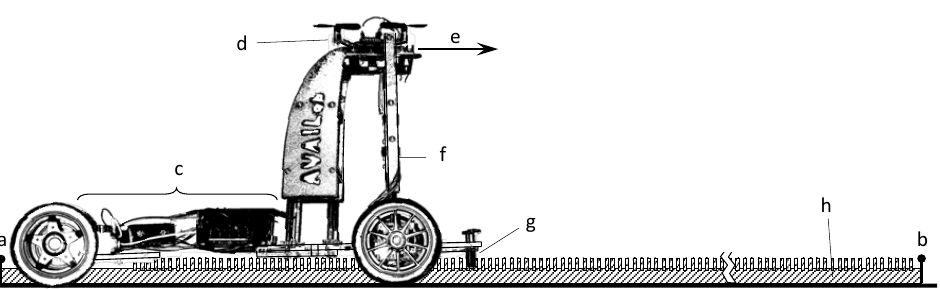
Figure 2. Dynamic experiment setup: mobile stand on rail; (a,b) beginning and end of rail; (h) op- tical obstacles (pins); (g) optical infrared sensor; (c) pcu, batteries, and motors; (d) Crazyflie 2.0 ; (e) direction of movement; (f) laser pointer. Optical sensor aligned with drone’s